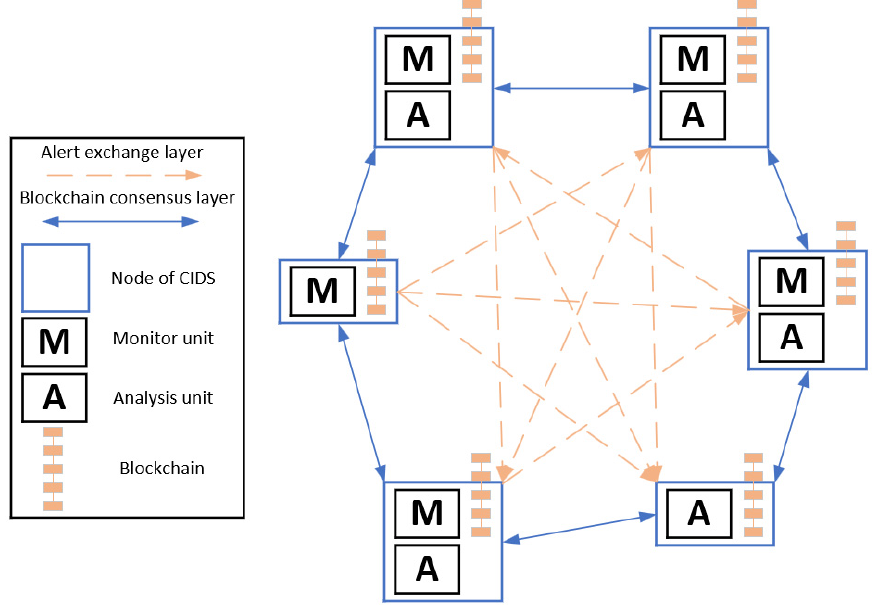
Figure 12. Architecture for the incorporation of blockchain into a CIDS.